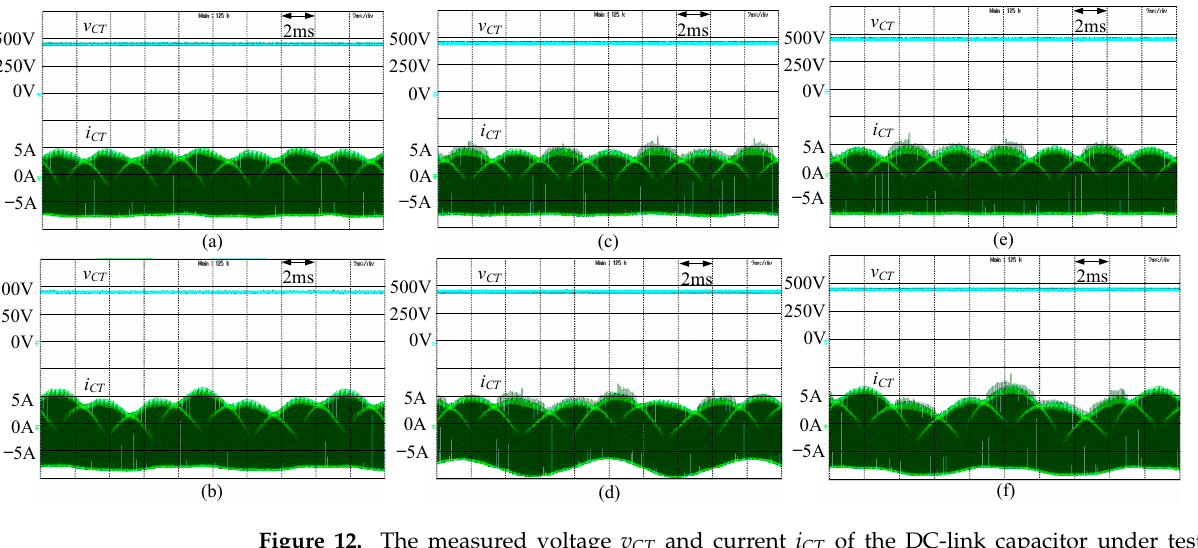
Figure 12. The measured voltage v CT and current i CT of the DC-link capacitor under test for ( a , c , e ) balanced and ( b , d , f ) unbalanced load conditions in the ( a , b ) full-scale voltage rating VSI, ( c , d ) conventional down-scale voltage rating evaluation system, and ( e , f ) proposed down-scale voltage rating evaluation